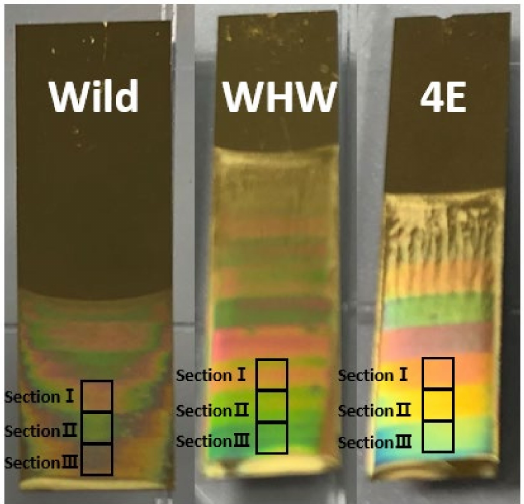
Figure 1. Wild, WHW, and 4E sensors containing the amino acid residues of glutamic acid (E)-glycine (G)-aspartic acid (D), tryptophan (W)-histidine (H)-tryptophan (W), and four repeating glutamic acids (E), respectively.